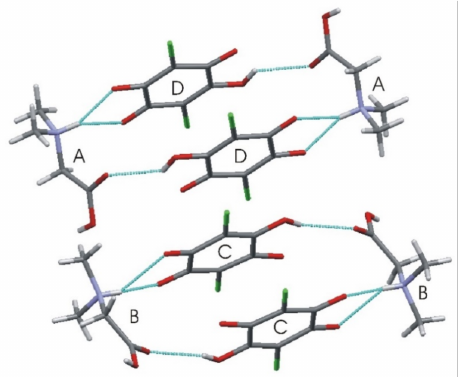
Figure 3. Characteristic ring aggregates in N,N-dimethylglycine–chloranilic acid